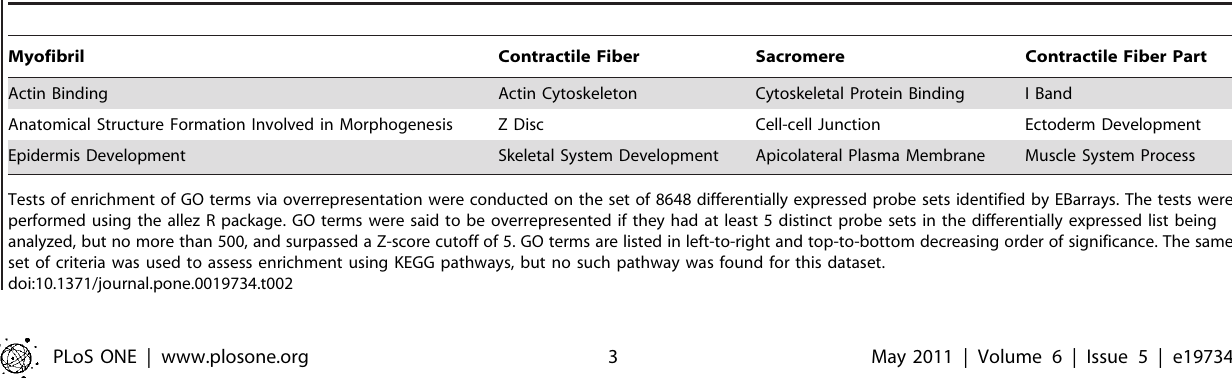
Table 2. Enriched Gene Ontology (GO) Terms.